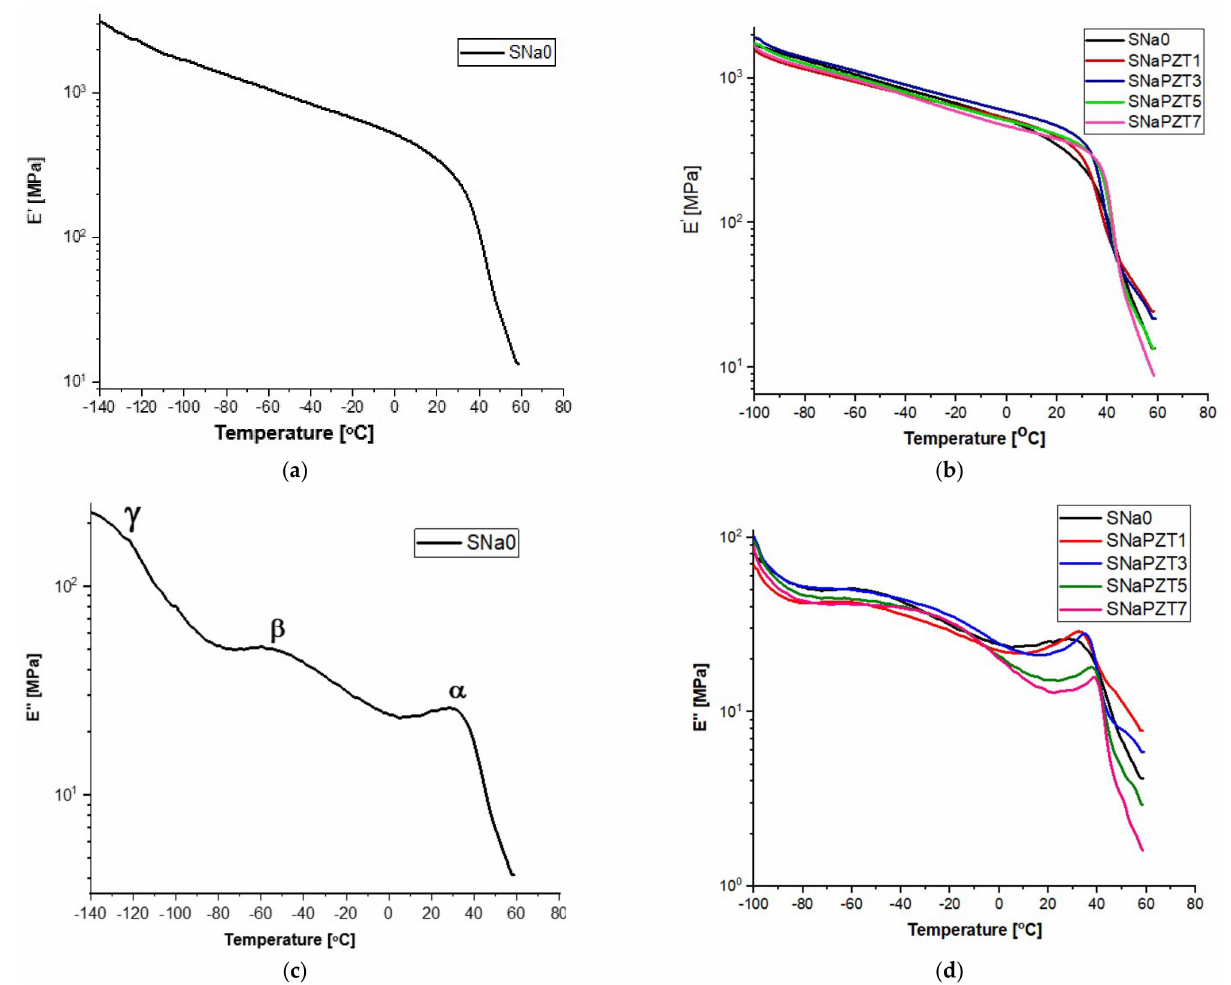
Figure 11. DMA curves: ( a ) E (cid:48) for SNa0 film; ( b ) E (cid:48) for different SNaPZT# films; ( c ) E (cid:48)(cid:48) for SNa0 film (with α , β and γ relaxations); ( d ) E (cid:48)(cid:48) for different SNaPZT#